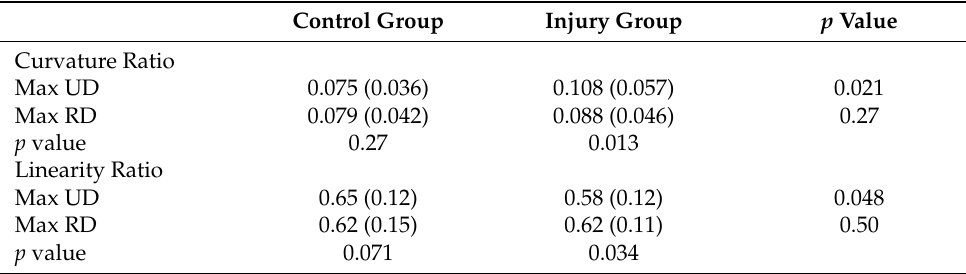
Table 1. The results of the curvature ratio and the linearity ratio.